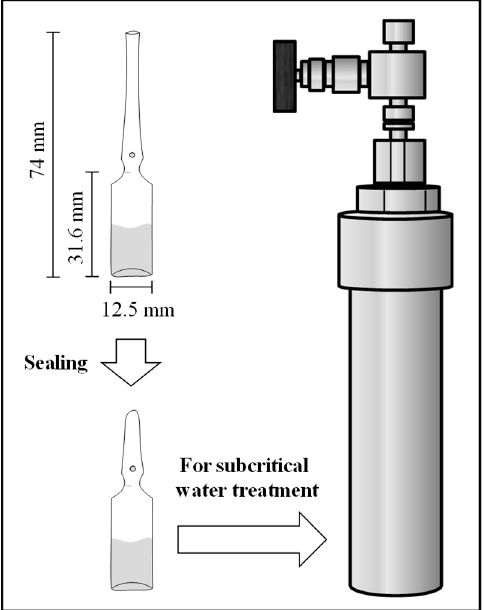
Figure 5. Illustration of small-scale subcritical water treatment.